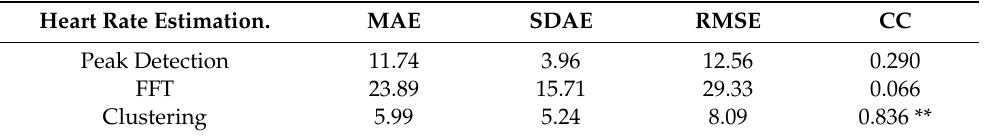
Table 4. Estimation of heart rates from the dataset including the motion artifacts by facial expressions and voluntary head motions.